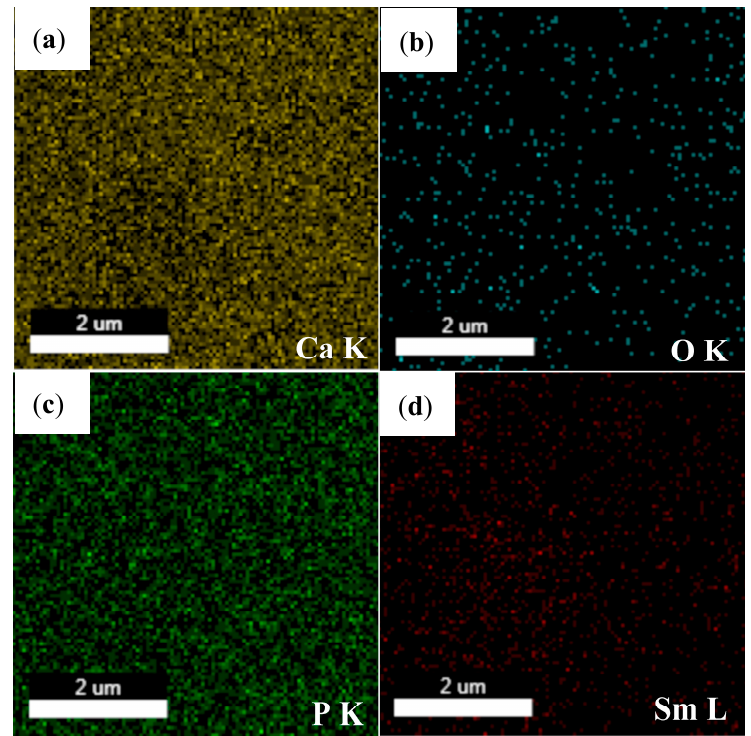
Figure 10. Elemental mapping analysis of the chemical constituent of 5SmHAp coating (Ca ( a ), O ( b ), P ( c ), Sm ( d )).